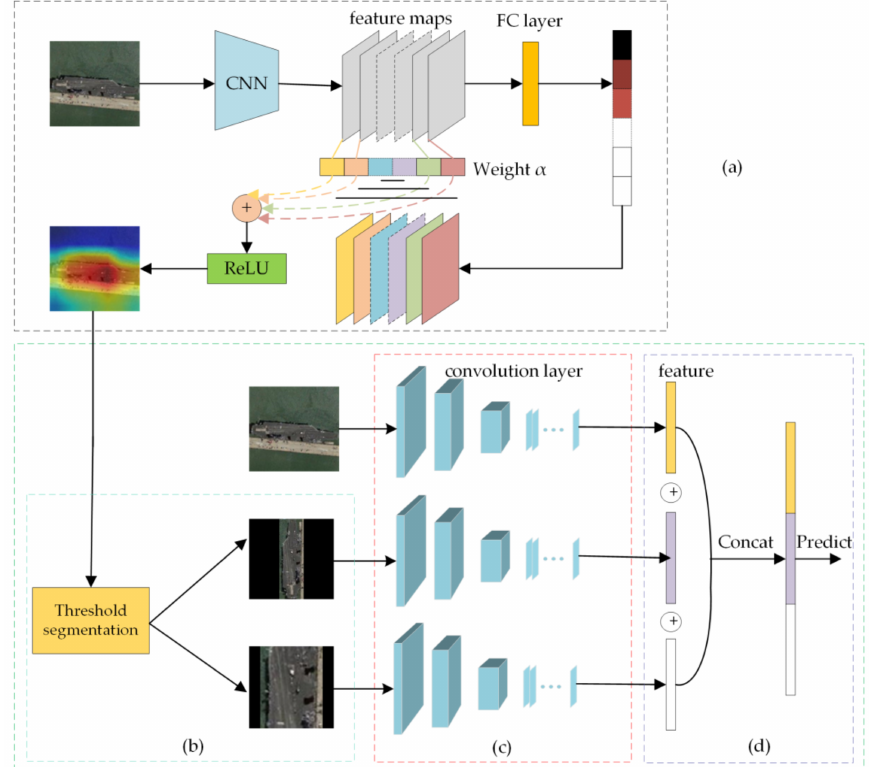
Figure 3. The framework of the proposed network. ( a ) Ship positioning network based on Grad-CAM; ( b ) two-stage image extraction network; ( c ) self-calibrated convolutions network; ( d ) feature fusion. First, we locate the ship image. The positioning image is then masked. The resulting different images are fed into a feature extraction network and classified.